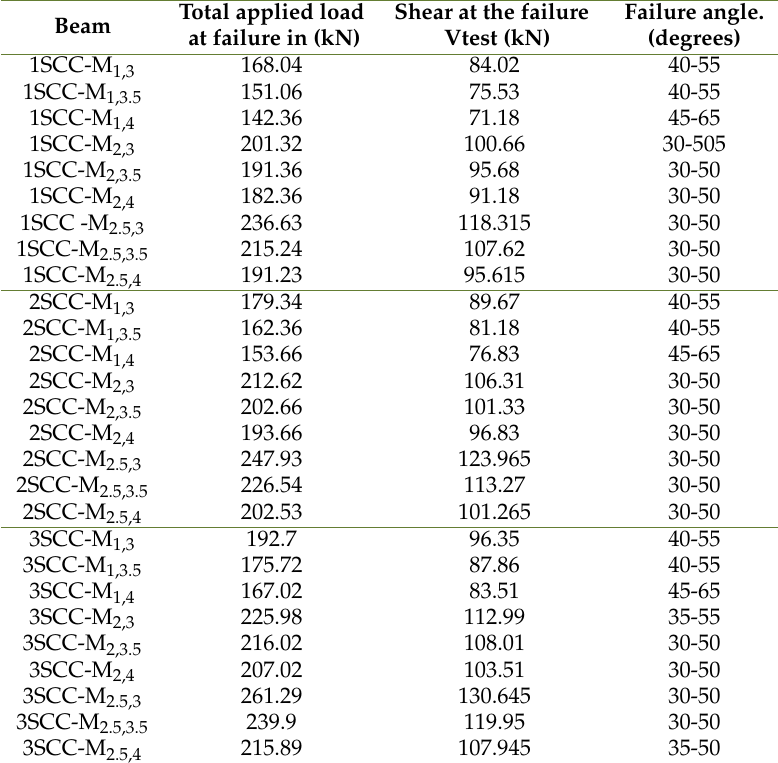
Table 4. Failure load and shear